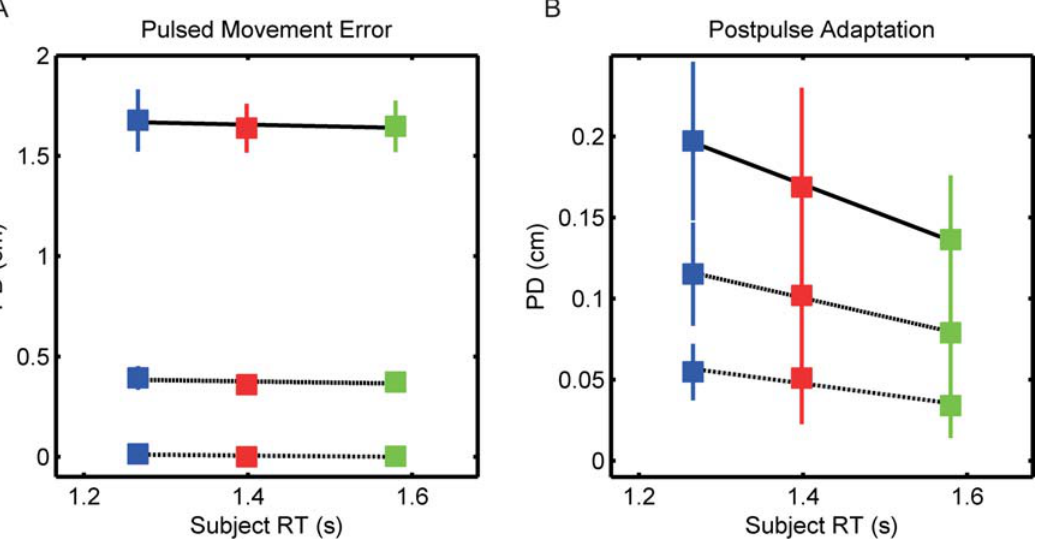
Figure 2. The effect of word categorization reaction time (RT) on within-movement feedback control and across-movement adaptation. Perpendicular displacements at 3 (dotted), 5 (dashed), and 7 cm (solid) in the pulsed (A) and postpulse movements (B) versus subject categorization RT for concrete (blue), abstract (red), and ambiguous (green) word categories in the pulsed movement. A) Word categorization RT was scaled by the semantic category; subjects responded progressively faster depending on the concreteness of the word. Neither semantic category nor RT affected within movement feedback control on pulsed movements. B) Postpulse adaptation was scaled by the word categorization RT. Subjects showed significantly more adaptation following pulsed movements with concrete words than pulsed movements with ambiguous words. Error bars represent the 95% confidence interval of the mean.